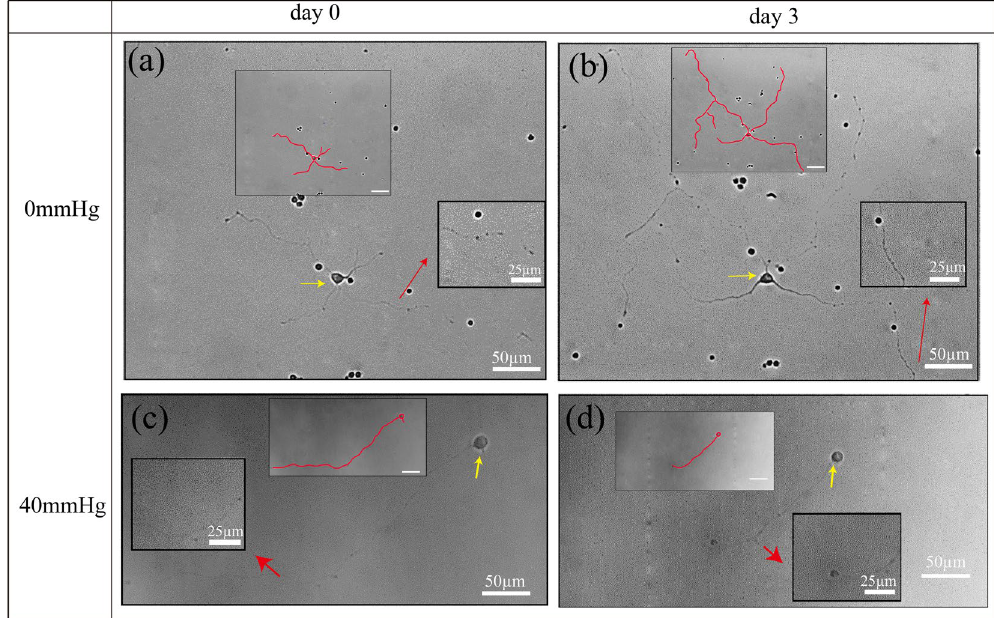
Figure 2. Representative phase contrast images and manually traced cell with neurites showing the same primary RGCs before and after 3 days of pressure elevation. ( a ) and ( c ) are images before pressure elevation, ( b ) and ( d ) are images after 3 days of 0 mmHg and 40 mmHg pressure elevation, respectively. Yellow and red arrows indicate the cell body and neurites, respectively.